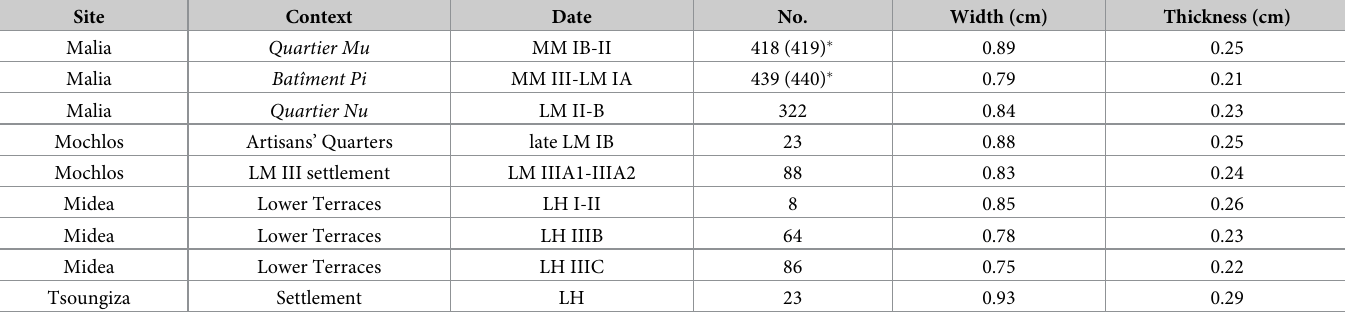
Table 4. Average width and thickness of prismatic blades from Cretan and mainland Middle–Late Bronze Age contexts. Data for Malia ([115] and this paper), Mochlos [128, 131], Midea and Tsoungiza [143].